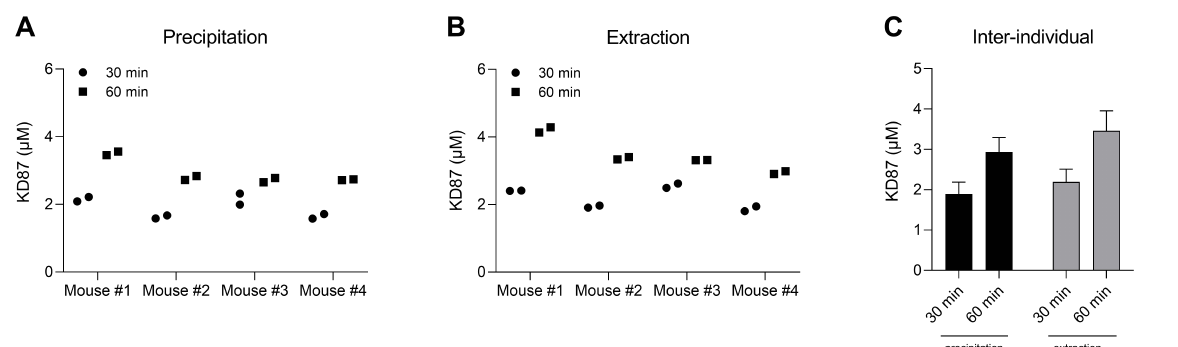
Figure 5. Quantification of KD87 in plasma of mice 30 and 60 min after intraperitoneal injection of KD87 (20 mg/kg body weight). Prior to sample processing, mouse plasma was diluted 1:5 with human plasma. Shown are the individual values of KD87 in mouse plasma ( A ) after protein precipitation and ( B ) after liquid-liquid extraction, as well as ( C ) the average KD87 concentration values of all four mice for both processing methods. ( A , B ): The values of two separately processed plasma aliquots of one blood sample per mouse are shown. ( C ): The bar chart summarizes the results of measurements from panels ( A , B ), expressed as mean ± standard deviation (SD) of n = 8 values per